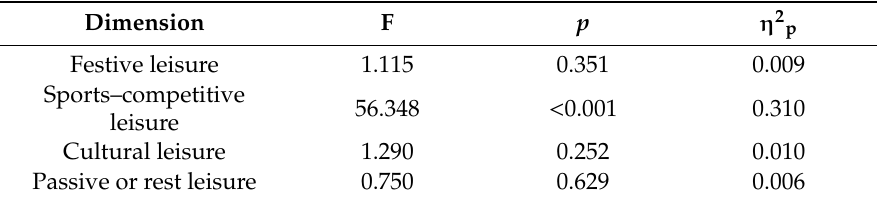
Table 5. ANOVA models for the components of